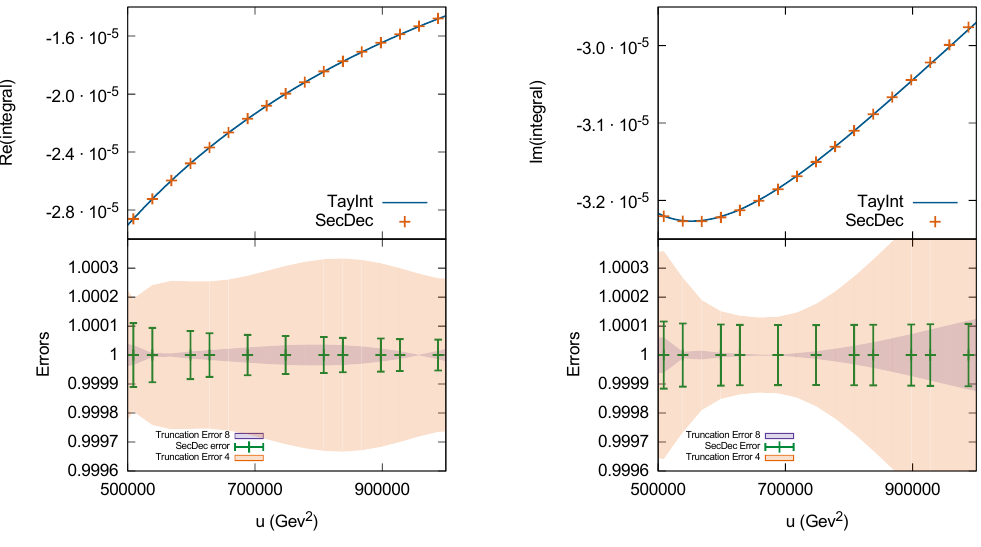
Figure 15 . I10 calculated at O ( (cid:15) 0 ) with a sixth-order series expansion. The scale u is over the 4 m 2 threshold, with the near threshold region excluded, and m 2 = 1 p plots show the relative TayInt , with 4 and 8 partitions, and SecDec uncertainties, respectively.